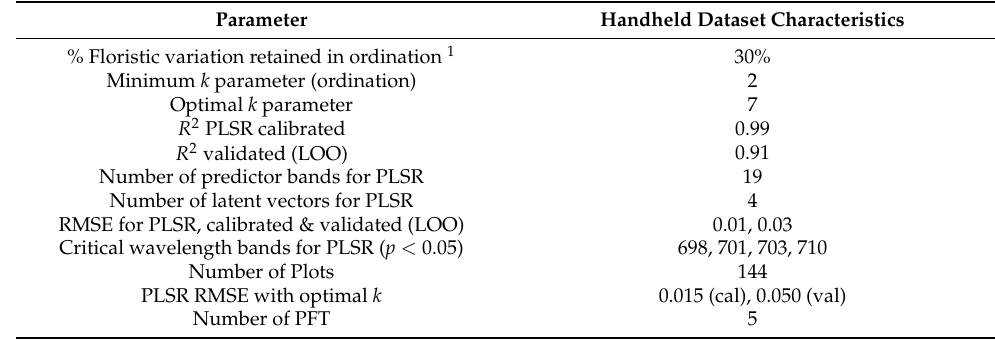
Figure 6. Regression lines from PLSR show how spectra from handheld measurements (Observed) predict PFT class membership (Predicted) with high accuracy (0.911). R2 = R 2 . Table 4. Results from the PLSR for the handheld spectrometer. PLSR results are shown for the 1st axis which describes the greatest amount of the